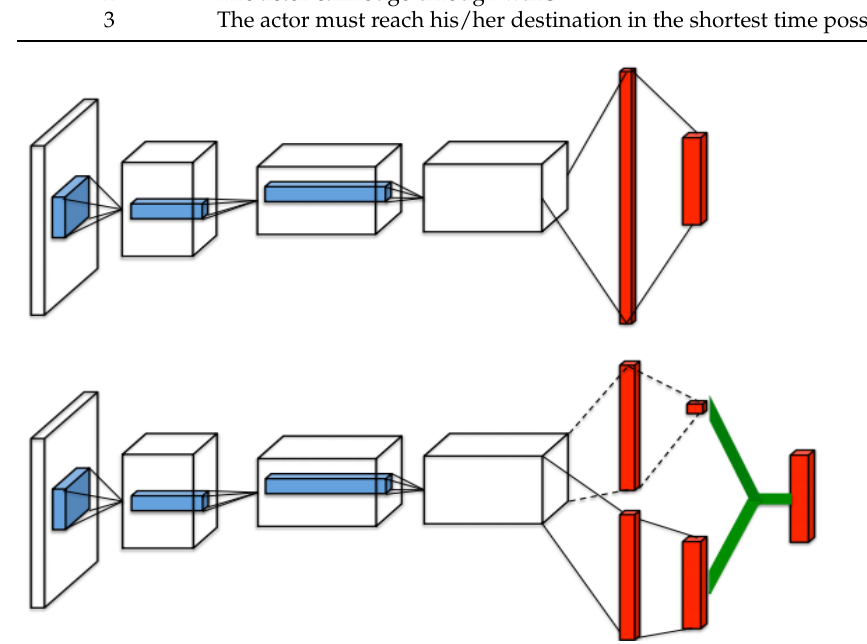
Figure 1. The structure of H-DQN. Table 1. Basic rules of the maze game.